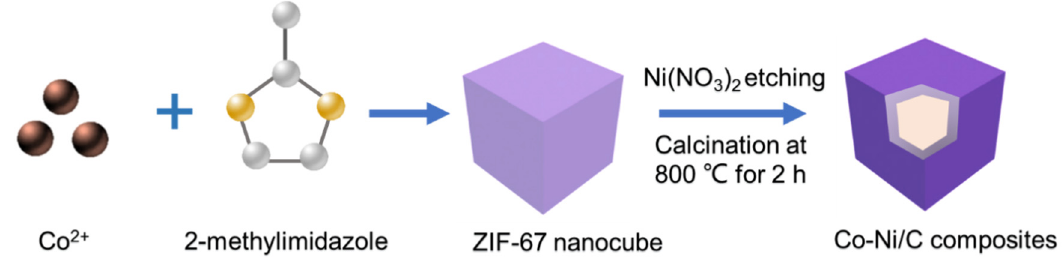
Figure 1. Schematic illustration of the fabrication of Co-Ni/C composites.